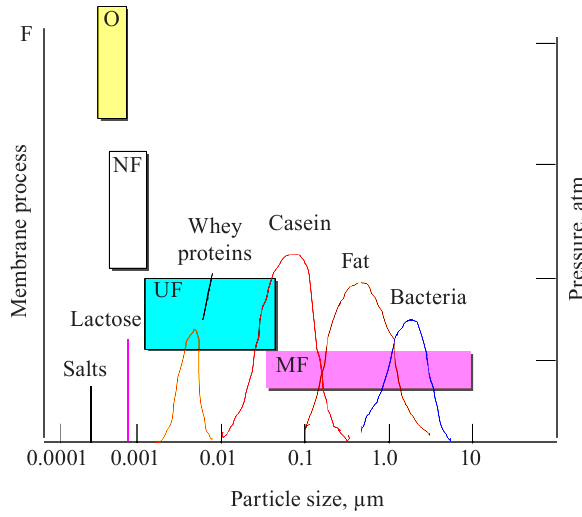
Figure 1 Diagrams of baromembrane separation of constituents of dairy raw materials: RO – reverse osmosis,